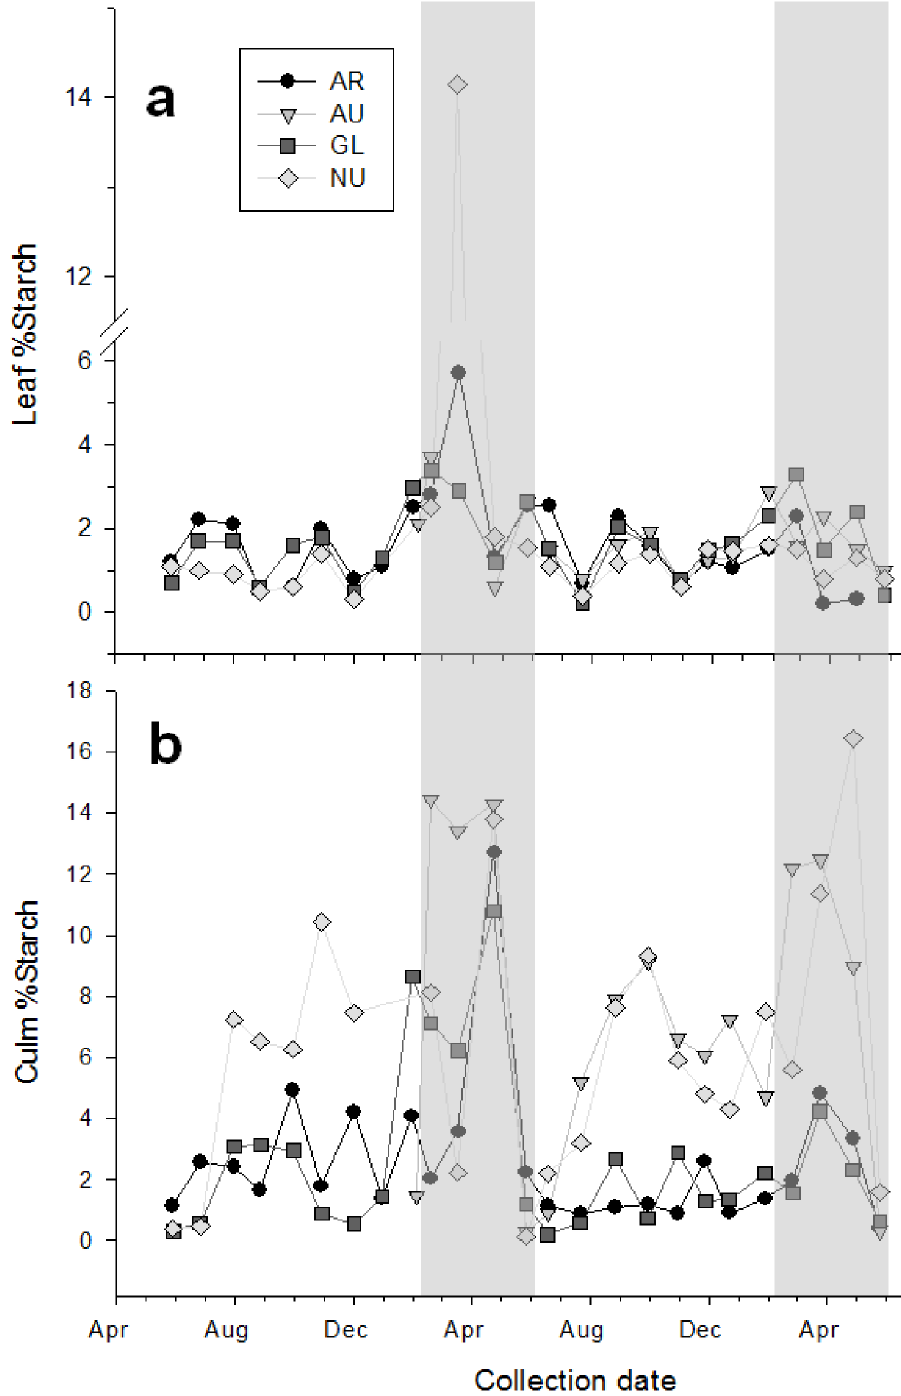
Fig 4. Starch content in bamboo leaves and culm. Starch concentrations for leaf (panela) and culm (panel b) of bamboospecies Phyllostachys ( P .) aurea (AR), P . aureosulcata (AU), P . glauca (GL), and P . nuda (NU). Samples were collectedonce per month over a periodof 18–27 mo. Data are expressedas a percentageof dry matter (DM). The shadedarea represents the time when captive giant pandas consumed primarily culm.